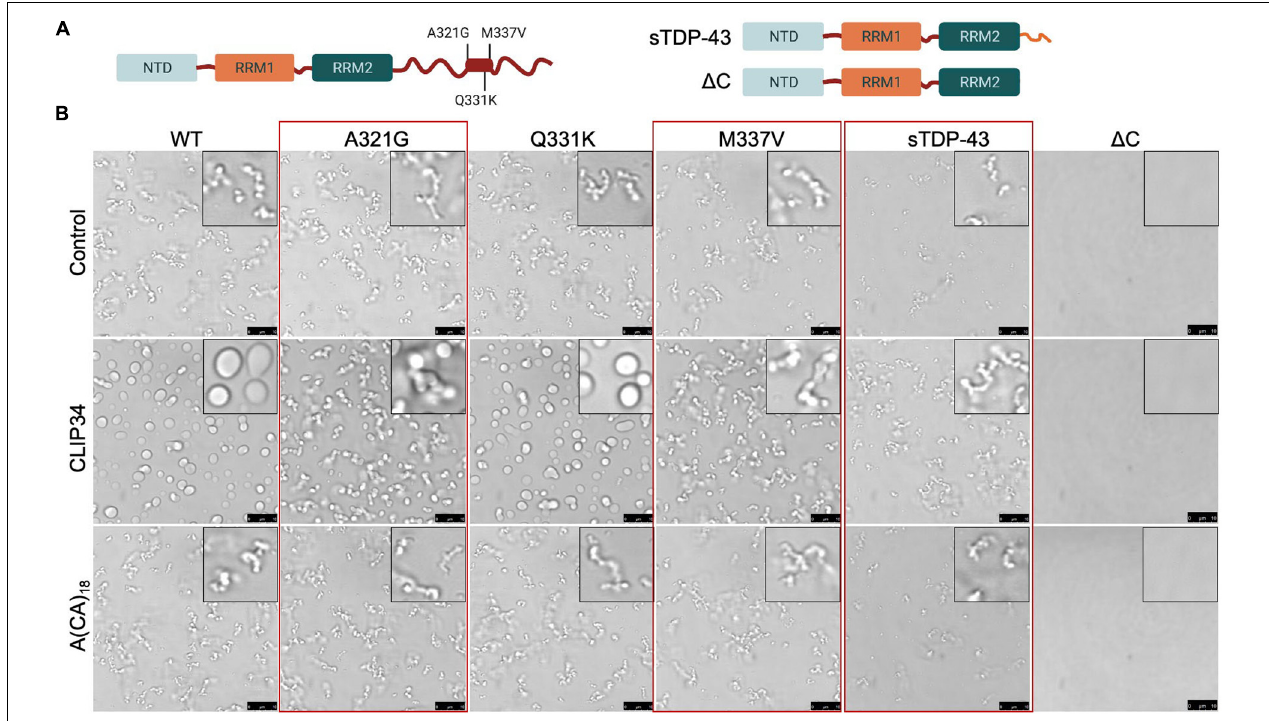
FIGURE 4 | Specific ALS-associated TDP-43 mutations disrupt the liquid properties of Clip34-induced LLPS and alter autoregulation. (A) Single site amino acid substitutions associated with ALS A321G, Q331K and M337V, part of a highly conserved region and partially α -helical structure in the C-terminal domain (boxed region), are indicated. In addition, sTDP-43 incorporating a unique 18 a.a. C-terminal sequence is compared to the truncation mutant lacking the entire CTD, (cid:49) C. (B) Phase separation of TDP-43 WT and mutants (4 µ M) observed by brightfield microscopy in the presence of no RNA control, CLIP34 or A(CA) 18 RNA (4 µ M) at 150 mM NaCl, pH 7.5. Red boxes highlight variants that show differences from WT. Representative images of 3 biological replicates from 2 protein preparations. Scale bars, 10 µ